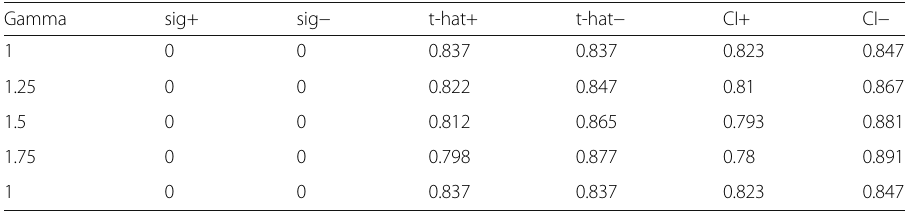
Table 11 Sensitivity